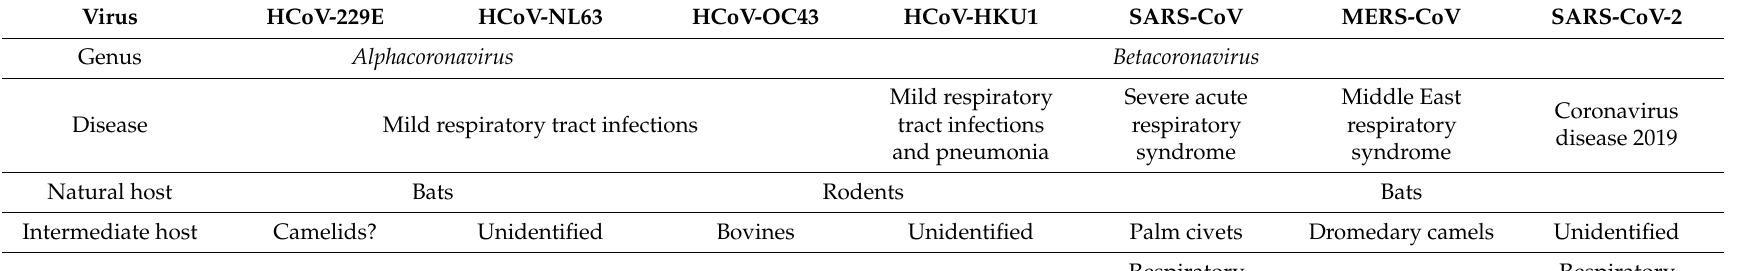
Table 3. Salient features of di ff erent zoonotic